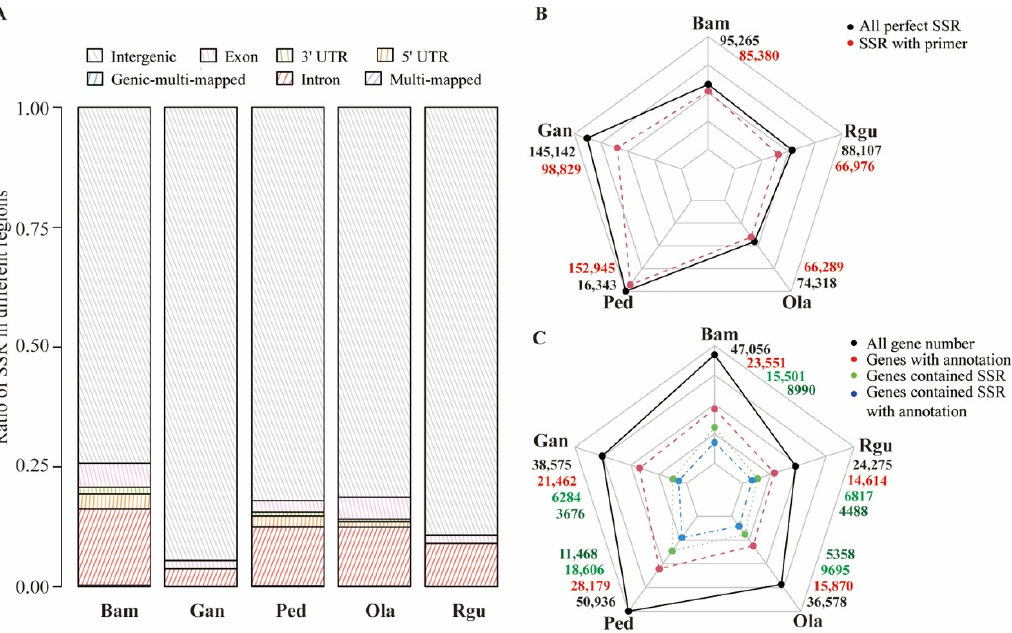
Figure 2. Comparison of the SSR characteristics among five bamboo species of B. amplexicaulis (Bam), G. angustifolia (Gan), P. edulis (Ped), O. latifolia (Ola), and R. guianensis (Rgu). ( A ) The distribution of SSRs located in different regions of genome in each bamboo species. ( B ) The total number of perfect SSRs and the number of perfect SSRs with successfully designed primers in each bamboo species. ( C ) The total number of genes, the total number of genes with Pfam annotations, the number of genes containing SSR, and the number of genes containing SSR with Pfam annotations in each bamboo species.